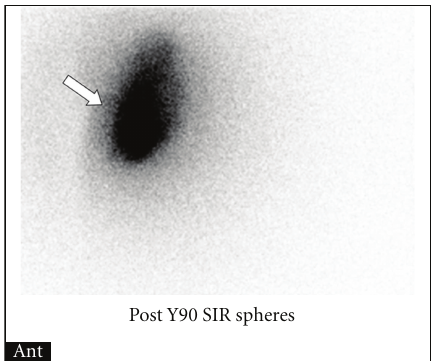
Figure 5: Posttherapy Bremsstrahlung image of the abdomen confirms proper delivery of microspheres to the targeted region of the right hepatic lobe (white arrow) without any abnormal extratumoral distribution. Safe and e ff ective microsphere radio- embolization with minimal to no radiotoxicity requires careful planning and